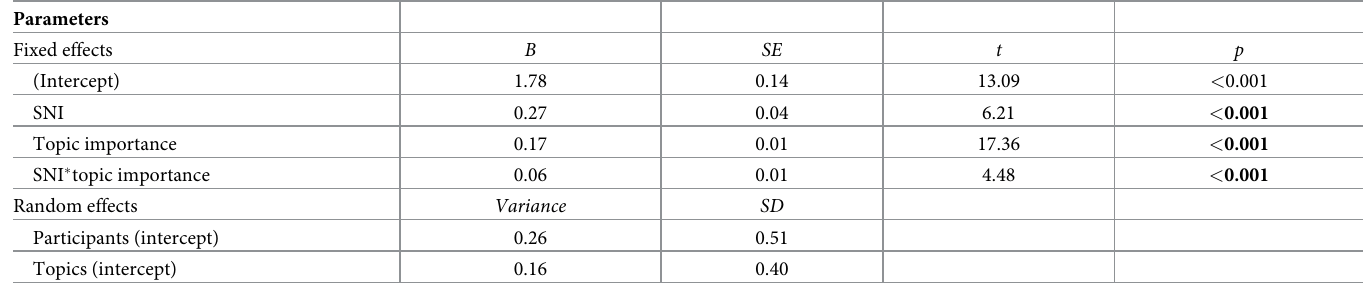
Table 3. Parameter estimates for testing topic importance as a moderator of the effect of SNI on OSN behavior.